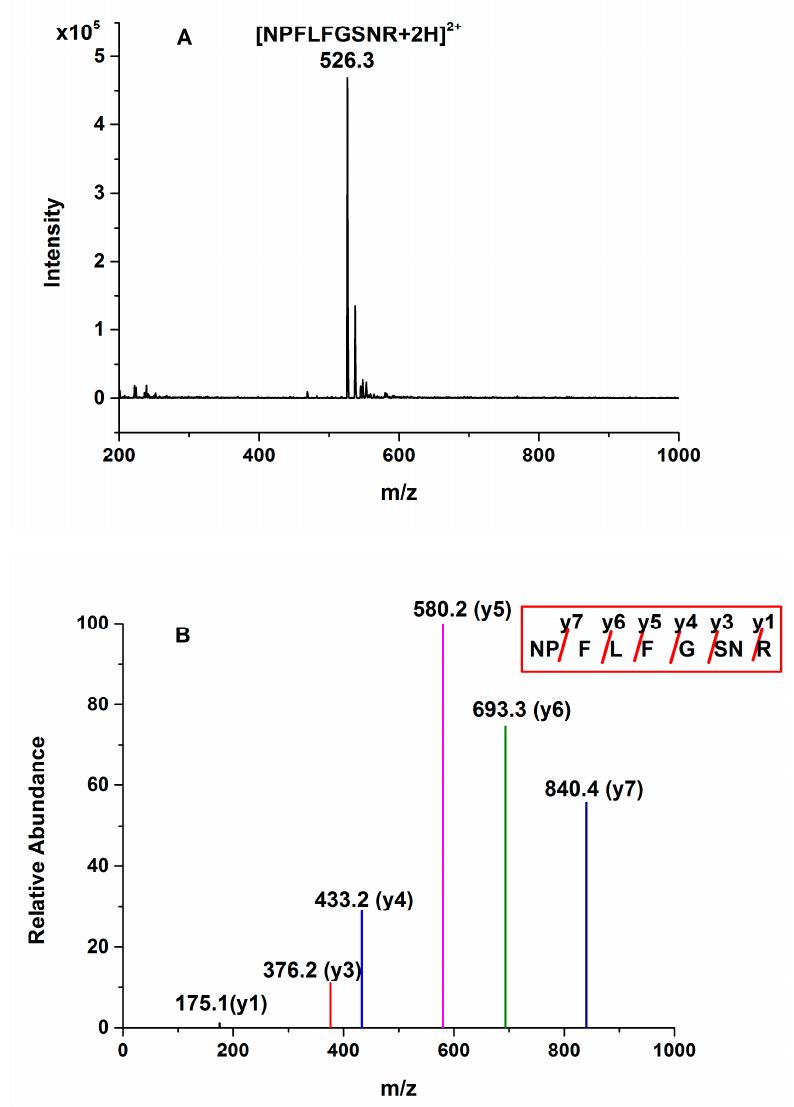
Figure 1. Full-scan ( A ) and product ion ( B ) spectra of the doubly-protonated peptide [NPFLFGSNR + 2H]